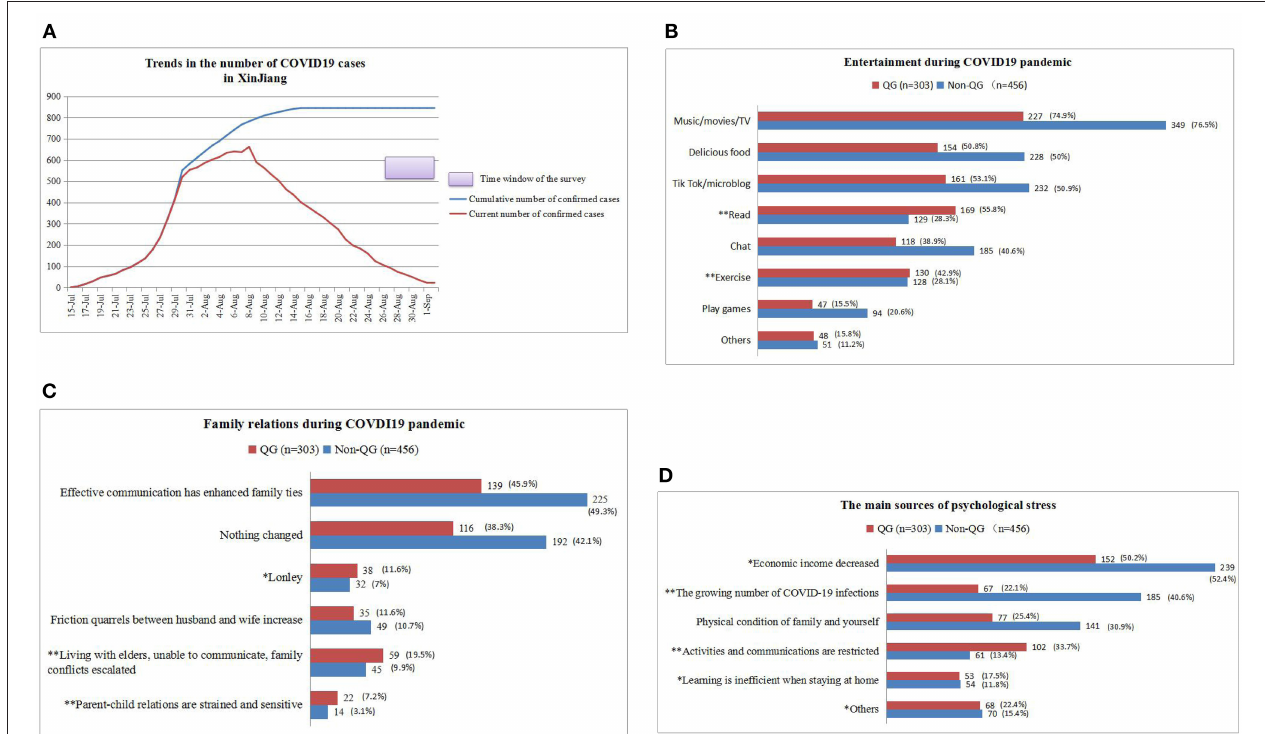
FIGURE 1 | The entertainment methods, family relationships, and sources of psychological stress of infertile women in QG and non-QG during the epidemic period. (A) The trend of number of COVID-19 pneumonia patients and the survey window for this study. (B) Entertainment methods of the two groups of people during the COVID-19 epidemic. (C) Changes in the family relationship between the two groups during the COVID-19 epidemic. (D) Sources of psychological stress for the two groups during the COVID-19 epidemic. Quarantined group (QG), non-quarantined group (Non-QG), * p < 0.05, ** p <